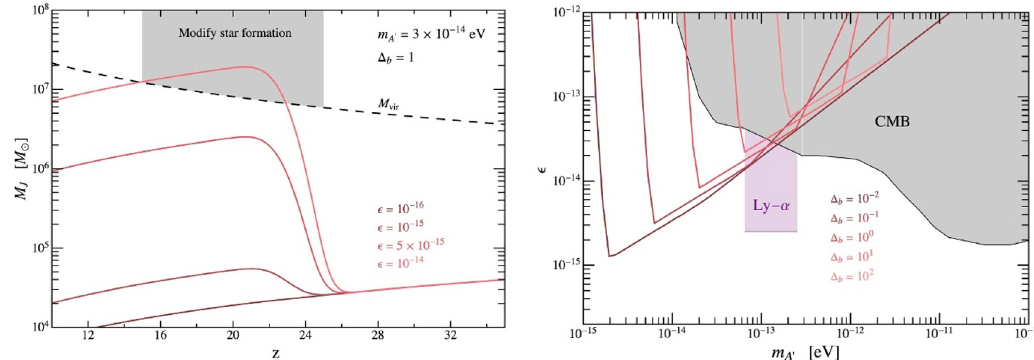
Figure 9 . Left: comparison of Jeans mass as a function of redshift assuming energy injected at (cid:1) b = 1 from a dark photon with mass 3 (cid:2) 10 (cid:0) 14 eV. The minimum virial mass required for star formation is shown in black dashed line (assuming star formation onsets when H 2 cooling becomes e(cid:14)cient, i.e. when the virial temperature of a halo is 10 4 K). Should M J > M vir over the entire interval 15 . z . 25, we expect star formation can be notably modi(cid:12)ed. Right: estimated sensitivity to the modi(cid:12)cation of the Jeans mass assuming modi(cid:12)cation to star formation is observed in various over and under-densities (cid:1) b